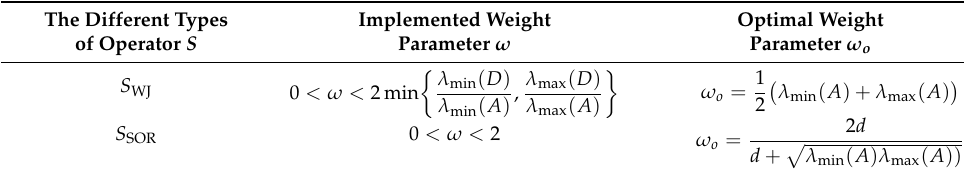
Table 2. Implemented weight parameter and optimal weight parameter of operator S